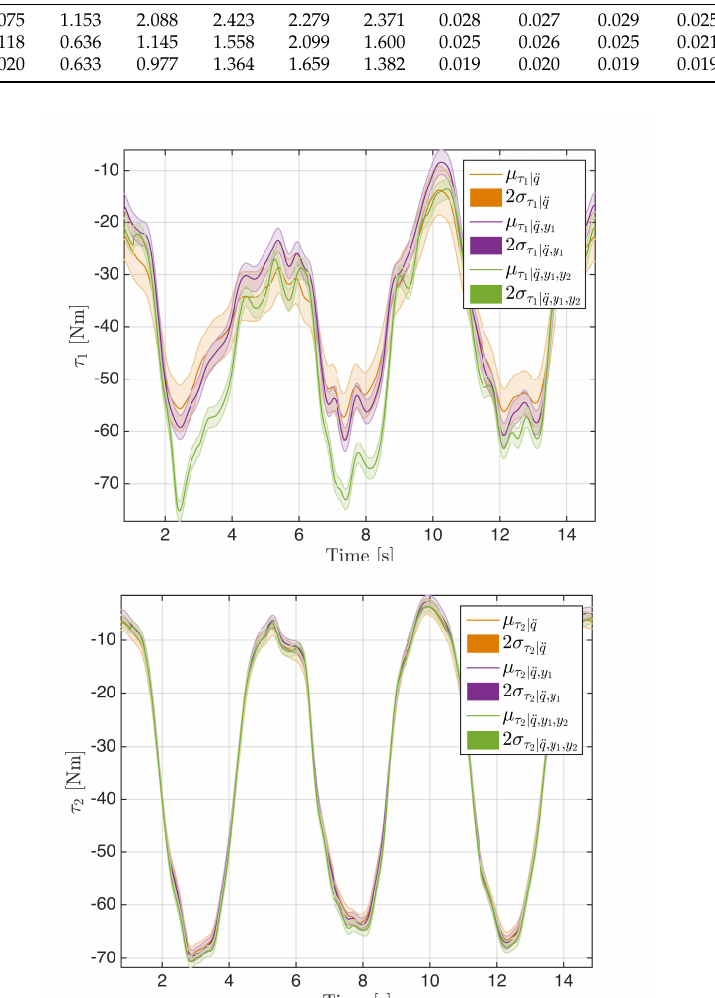
Figure 7. Mean ( µ ) and standard deviation (2 σ ) for the estimation of τ increasing the number of